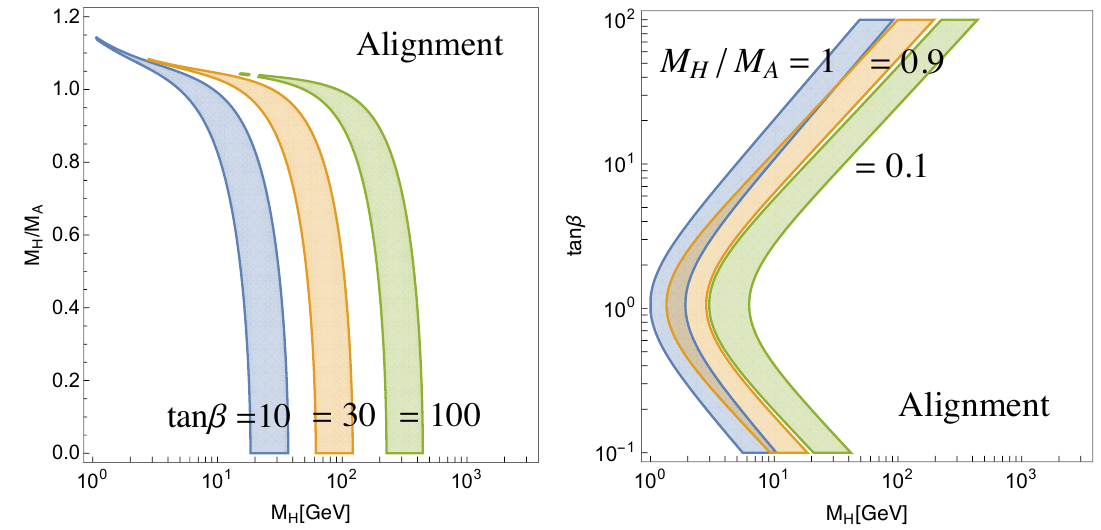
Figure 3 . Parameter space preferred by the muon g (cid:0) 2 anomaly at 2 (cid:27) level. Left: allowed regions in the ( M H ; M A ) plane for tan (cid:12) = 10 (blue), 30 (orange) and 100 (green); right: allowed regions in the ( M H ; tan (cid:12) ) plane for M H =M A = 1 (blue), 0 : 9 (orange) and 0.1